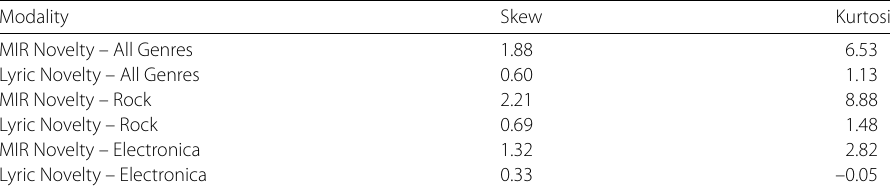
Table 2 Novelty Score